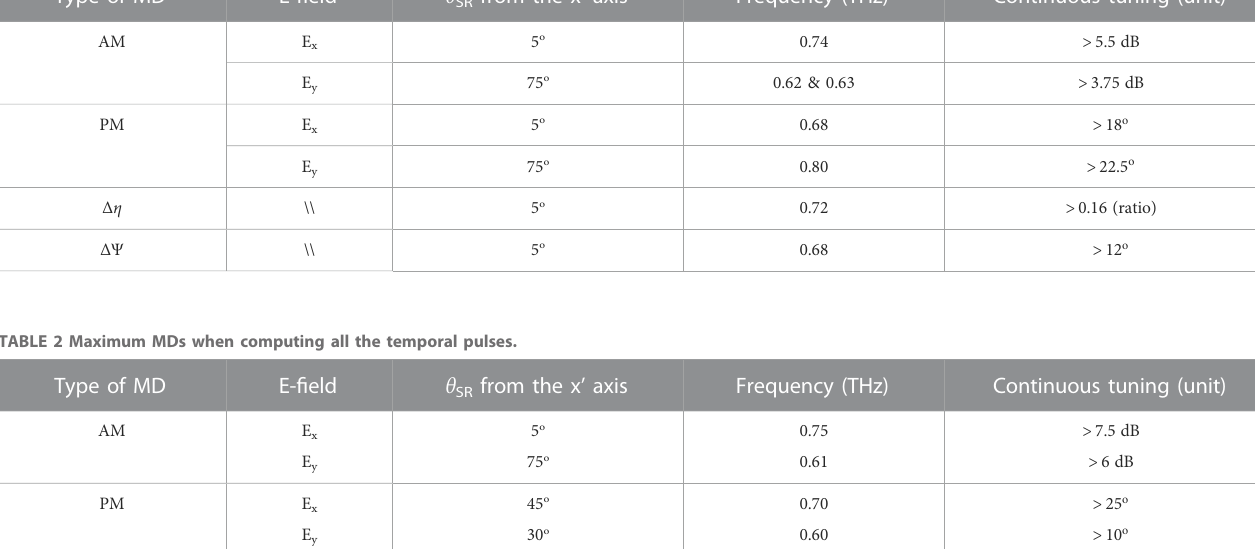
TABLE 1 Maximum MDs without considering multiple re fl ections. Type of MD